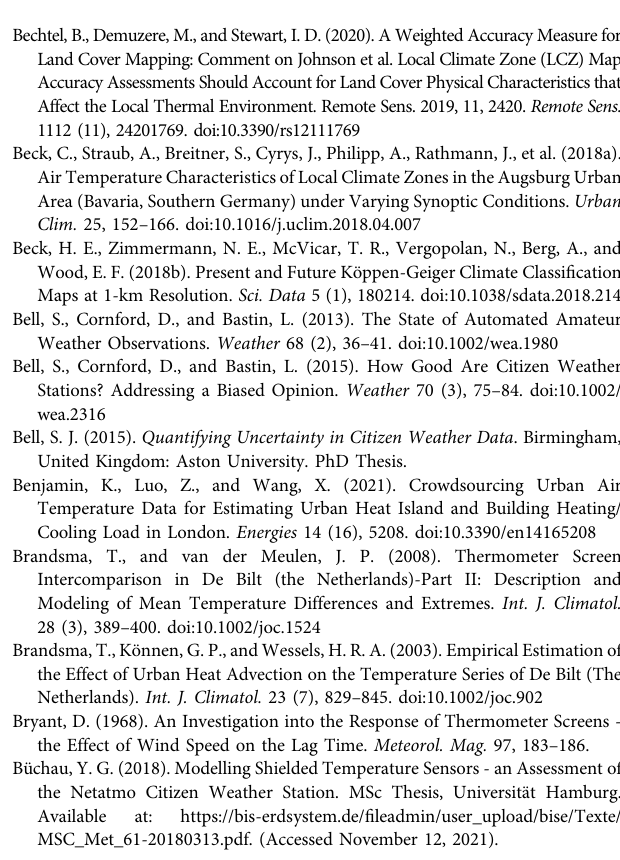
table/. PRWS datafor Amsterdamfromthe AAMS are available upon request from Gert-Jan Steeneveld or Bert Heusinkveld at Wageningen University & Research. Data from the KNMI can freely be obtained at